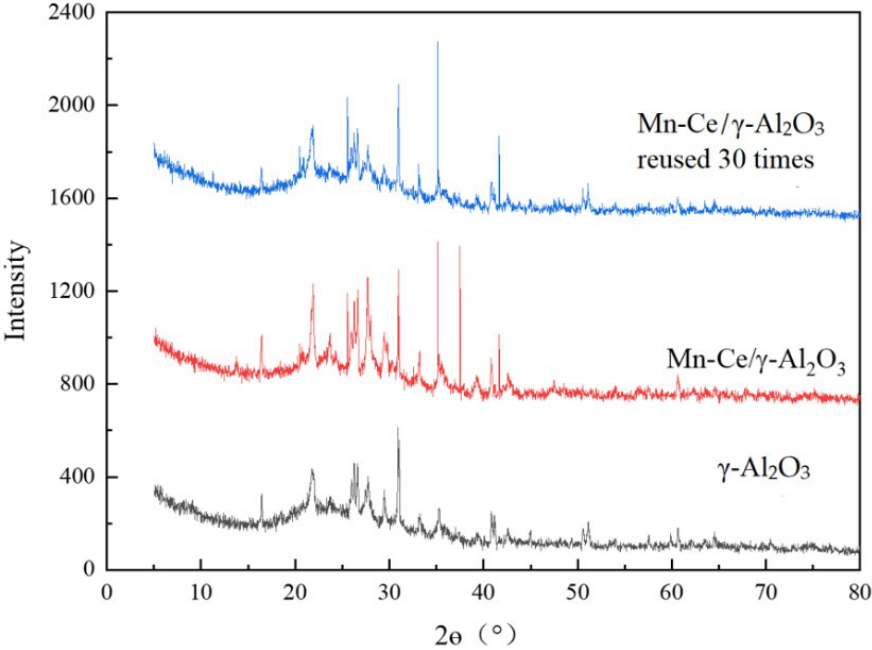
Figure 3. XRD characterization of Mn-Ce/ γ -Al 2 O 3 catalysts.